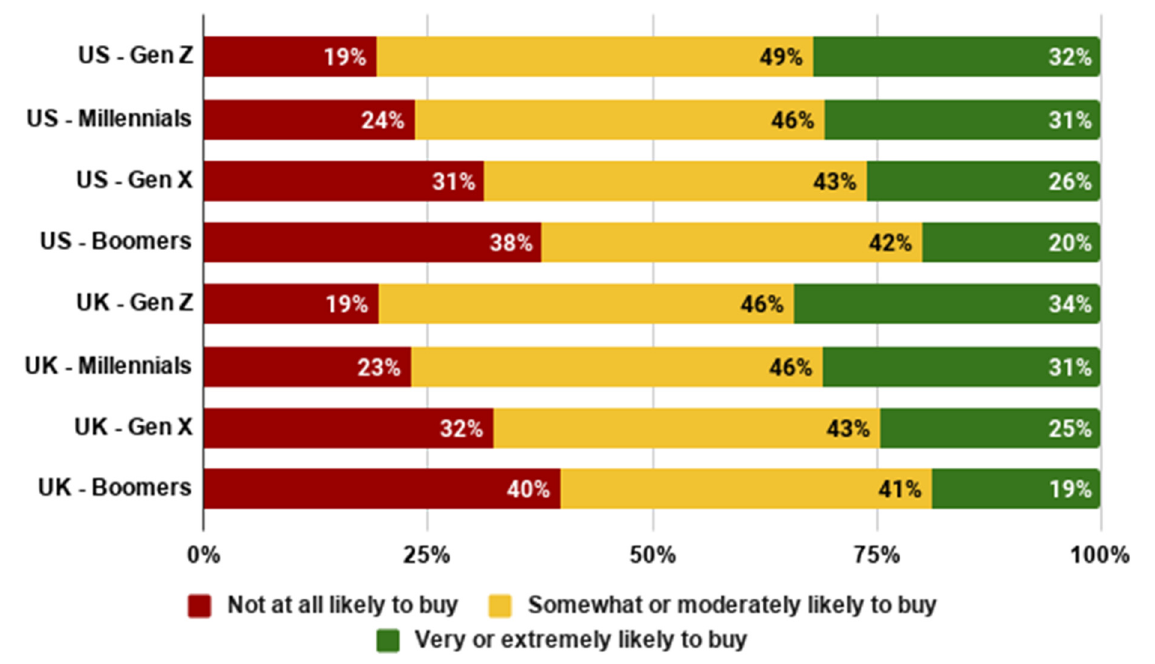
Figure 13. Likelihood of buying cultivated meat by generation.